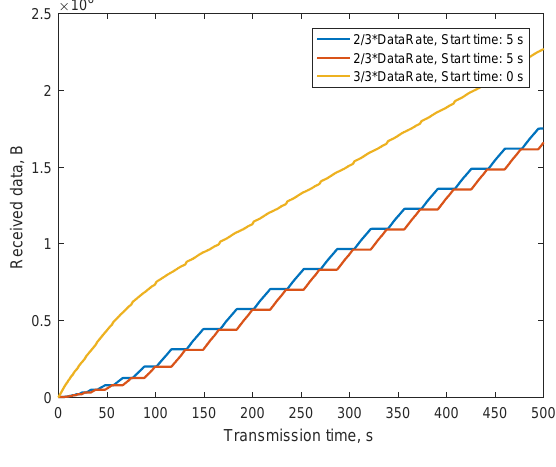
Figure 15. Scenario